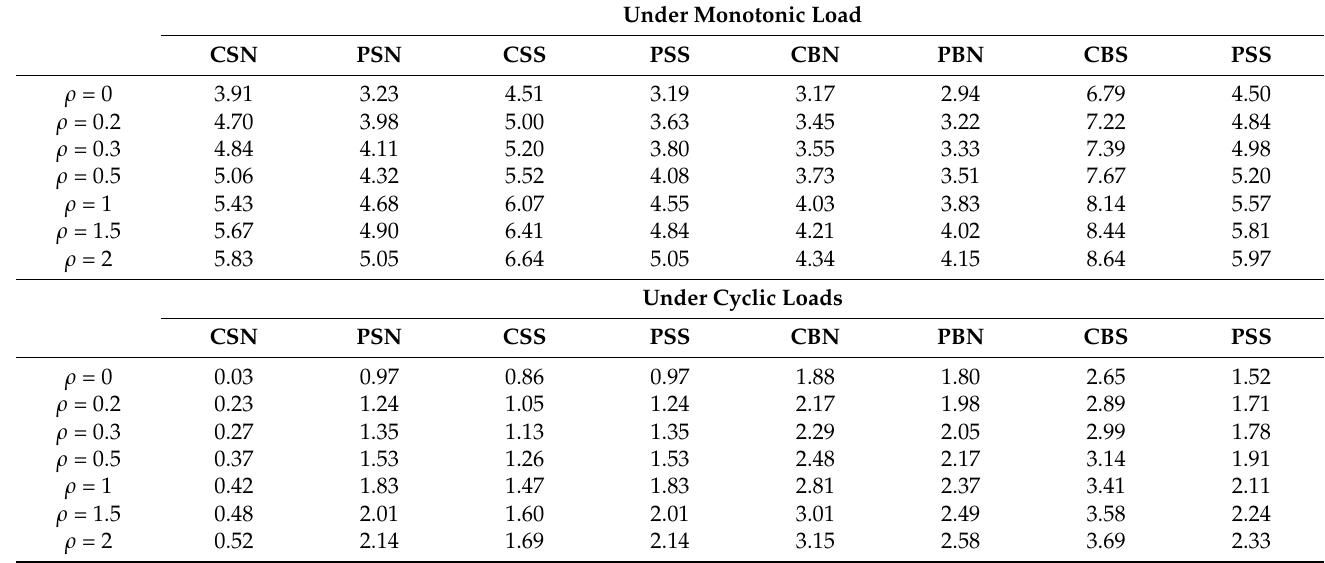
Table 5. Reliability index of the design values calculated by GB50005.